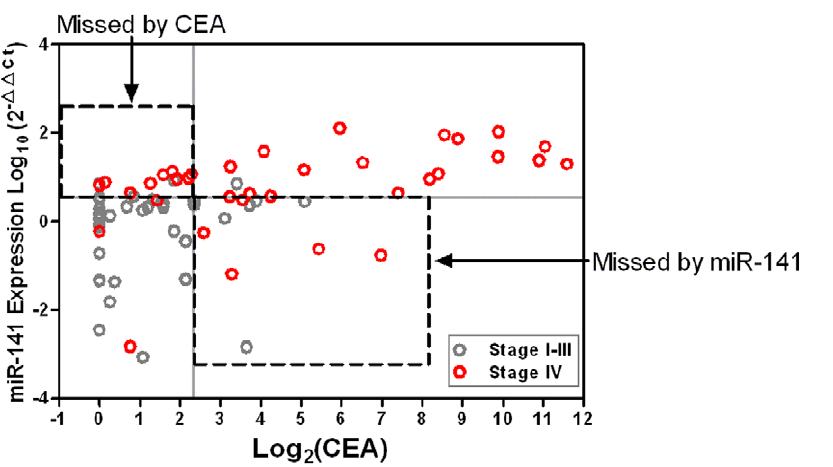
Figure 3. Combination of CEA and miR-141 identifies additional Stage IV cases in the training cohort. Two-parameter (expression of miR-141 and CEA in plasma) classification is used to discriminate distant metastatic colon cancer. The cut-off value for CEA is 5.0 ng/mL, and for miR- 141 is 16.77 defined from the ROC curve. The corresponding cut-off values are marked by grey lines.